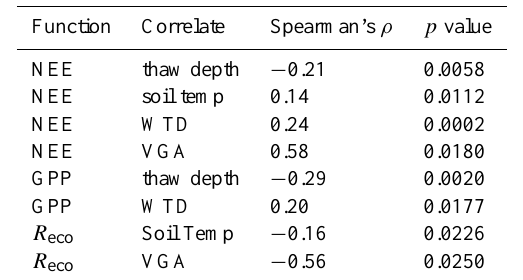
Table 3. Abiotic and biotic relationships with gross primary pro- duction (GPP = NEE − R eco ), net ecosystem exchange (NEE) and ecosystem respiration ( R eco ). R eco has negative values and there- fore, negative correlation signifies that larger VGA or soil temp have higher R eco . Similarly, since thaw depth has negative values, neg- ative correlations with GPP and NEE mean that deeper frost tables relate to greater GPP and